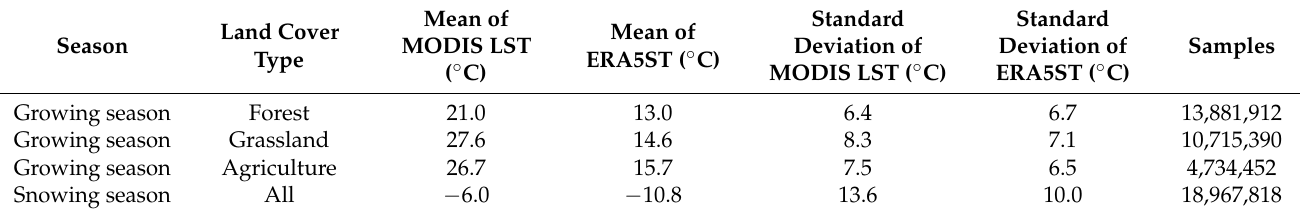
Table 2. Comparison of the mean and standard deviation of MODIS LST and ERA5ST (all valid pixel samples are used).